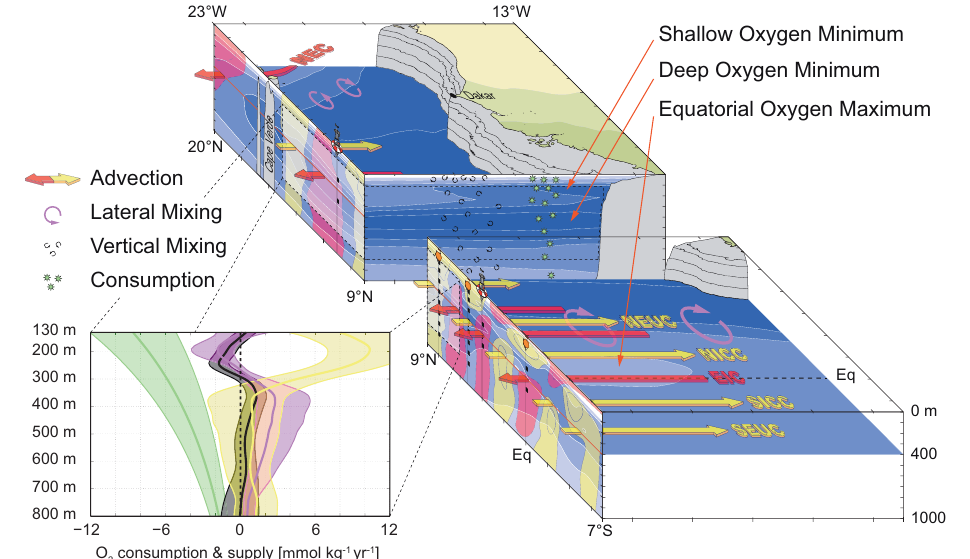
Figure 21. Schematic of the functioning of the ETNA OMZ and its oxygen budget. In the upper box, the oxygen distribution (bluish colours with dark/light blue corresponding to low/high oxygen) is shown at the sections along 23 ◦ W and 9 ◦ N and at a depth of 400m; in the lower right box it is shown at the section along 23 ◦ W and at a depth of 400m. Red and yellow areas at the 23 ◦ W section correspond to westward and eastward flow also marked by red and yellow arrows, respectively. The oxygen budget (lower left panel) includes physical supply by meridional (violet curve) and vertical mixing (black curve) as well as consumption after Karstensen et al. (2008) (green curve). The yellow curve is the residual of the other three terms, which is dominated by zonal advection. All error estimates (coloured shadings) are referred to a 95% confidence (except the isopycnal meridional eddy supply, where the error was estimated from both the error of the oxygen curvature (95% confidence) and the error of the eddy diffusivity (factor 2 assumed)) (see further details in the text and in Hahn et al.,